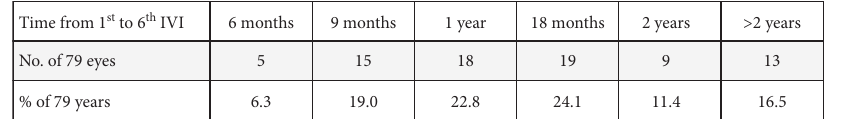
Figure 1: Time taken to deliver ≥ 6 anti-VEGF intravitreal injections. Notes: IVI: intravitreal injection; Mt: month; VEGF: vascular endothelial growth factor; Yr: year. Table 2: Overall rate of anti-VEGF